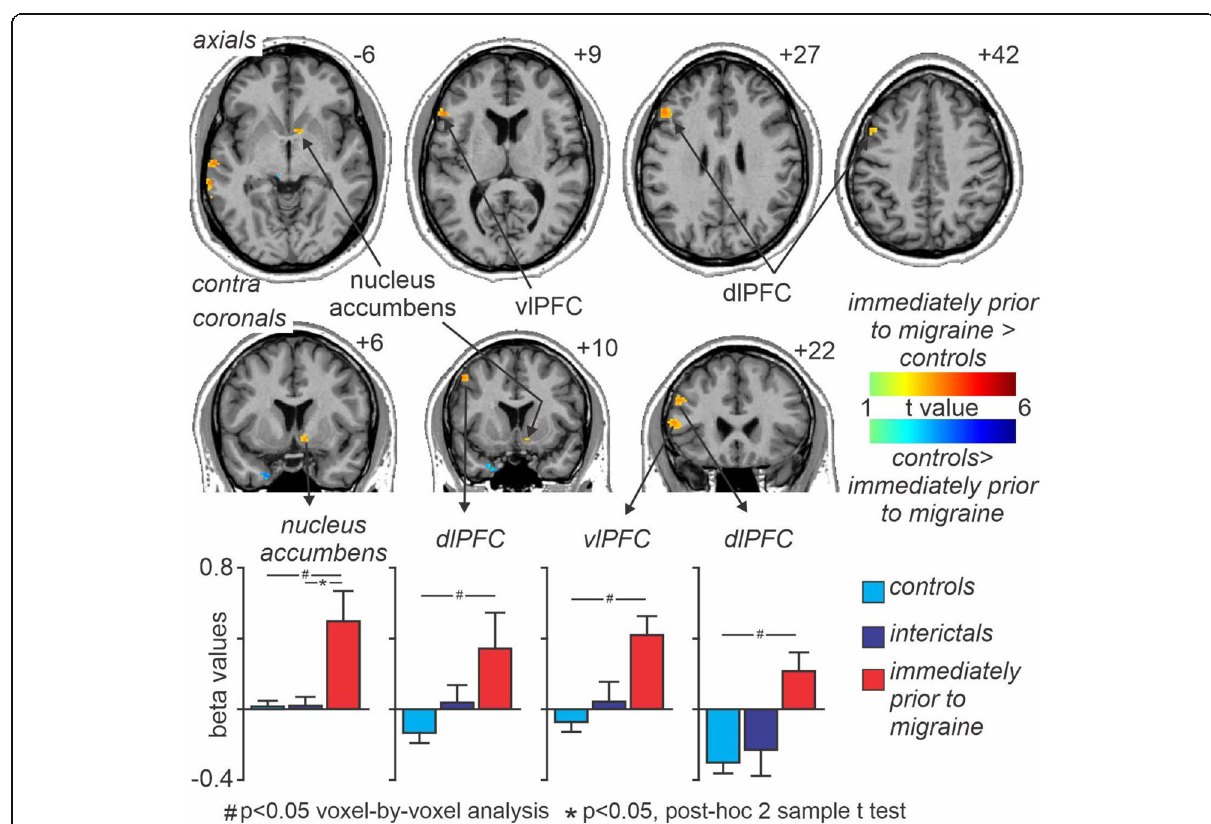
Fig. 3 Significant differences in signal intensity changes during 8 noxious thermal stimuli in migraineurs immediately prior to a migraine headache compared with controls. Significant clusters are overlaid onto a mean T1-weighted anatomical image. Slice locations in Montreal Neurological Institute space are indicated to the top right of each slice. Note that signal increase changes were significantly greater in four main regions; the ipsilateral nucleus accumbens, contralateral ventrolateral prefrontal cortex (vlPFC) and two clusters in the dorsolateral prefrontal cortex (dlPFC). Plots of mean (±SEM) beta values (effect sizes) for each of these four clusters revealed that acute orofacial pain evoked significant